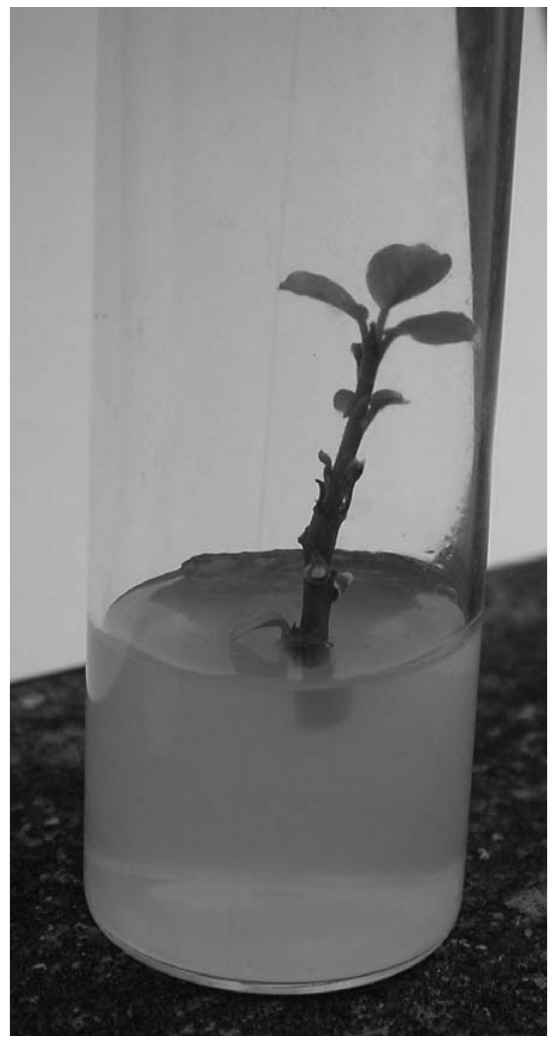
Fig. 1. Sterilized green caper shoot in a bijou plastic